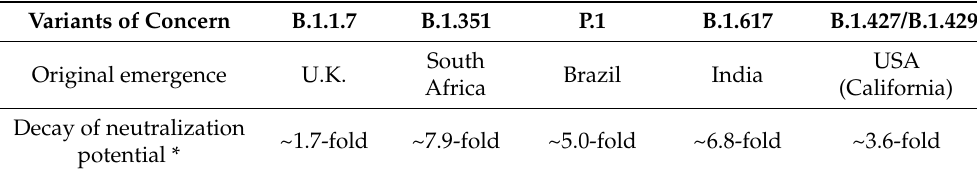
Table 1. Decay of the neutralization potential of anti-SARS-CoV-2 antibodies against the currently known variants of concern (VOCs) compared to the prototype SARS-CoV-2 strain.